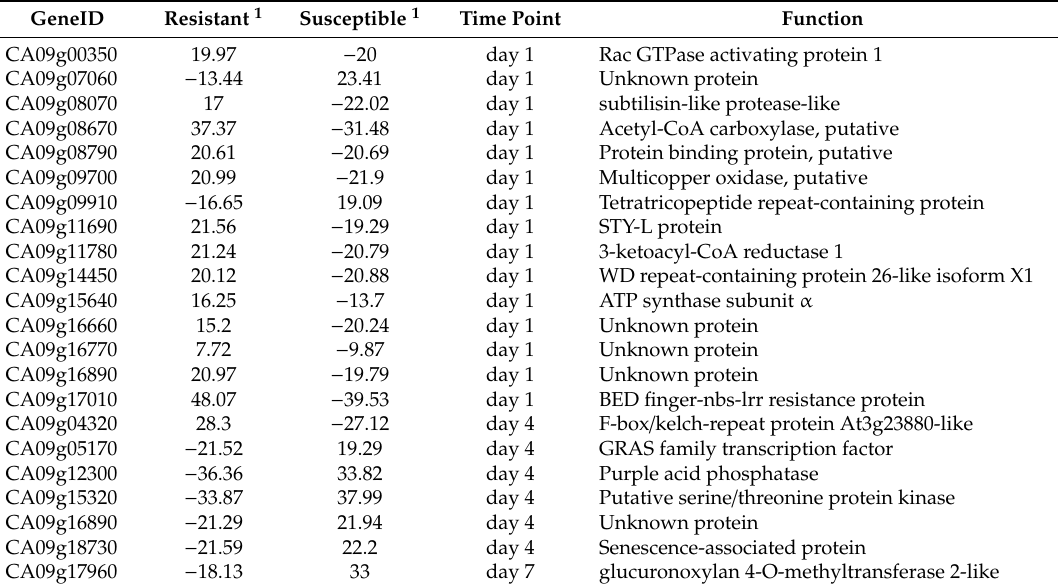
Table 1. Select directionally DEG located within chromosome P9.